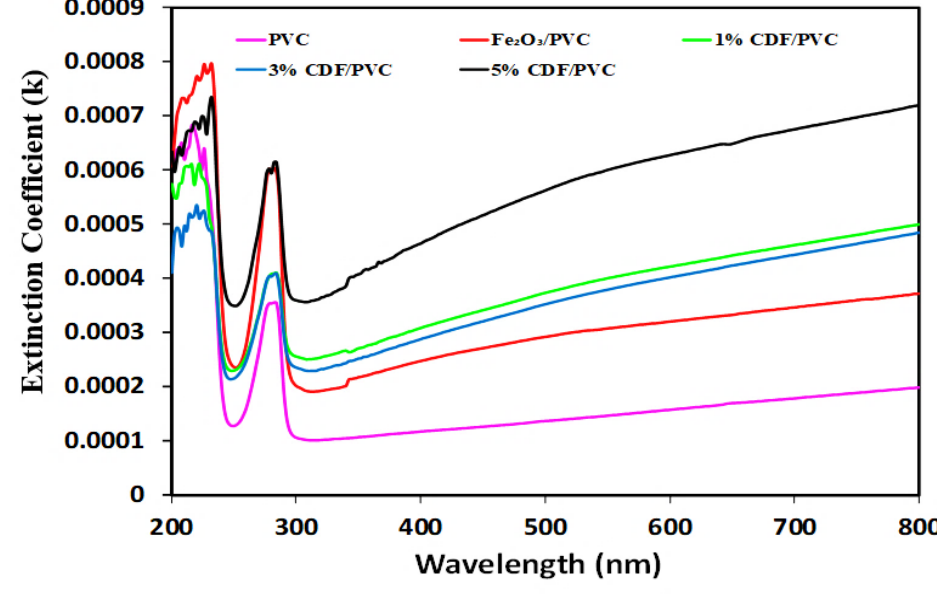
Figure 9. A comparison of extinction coefficient spectra of PVC and its composites.